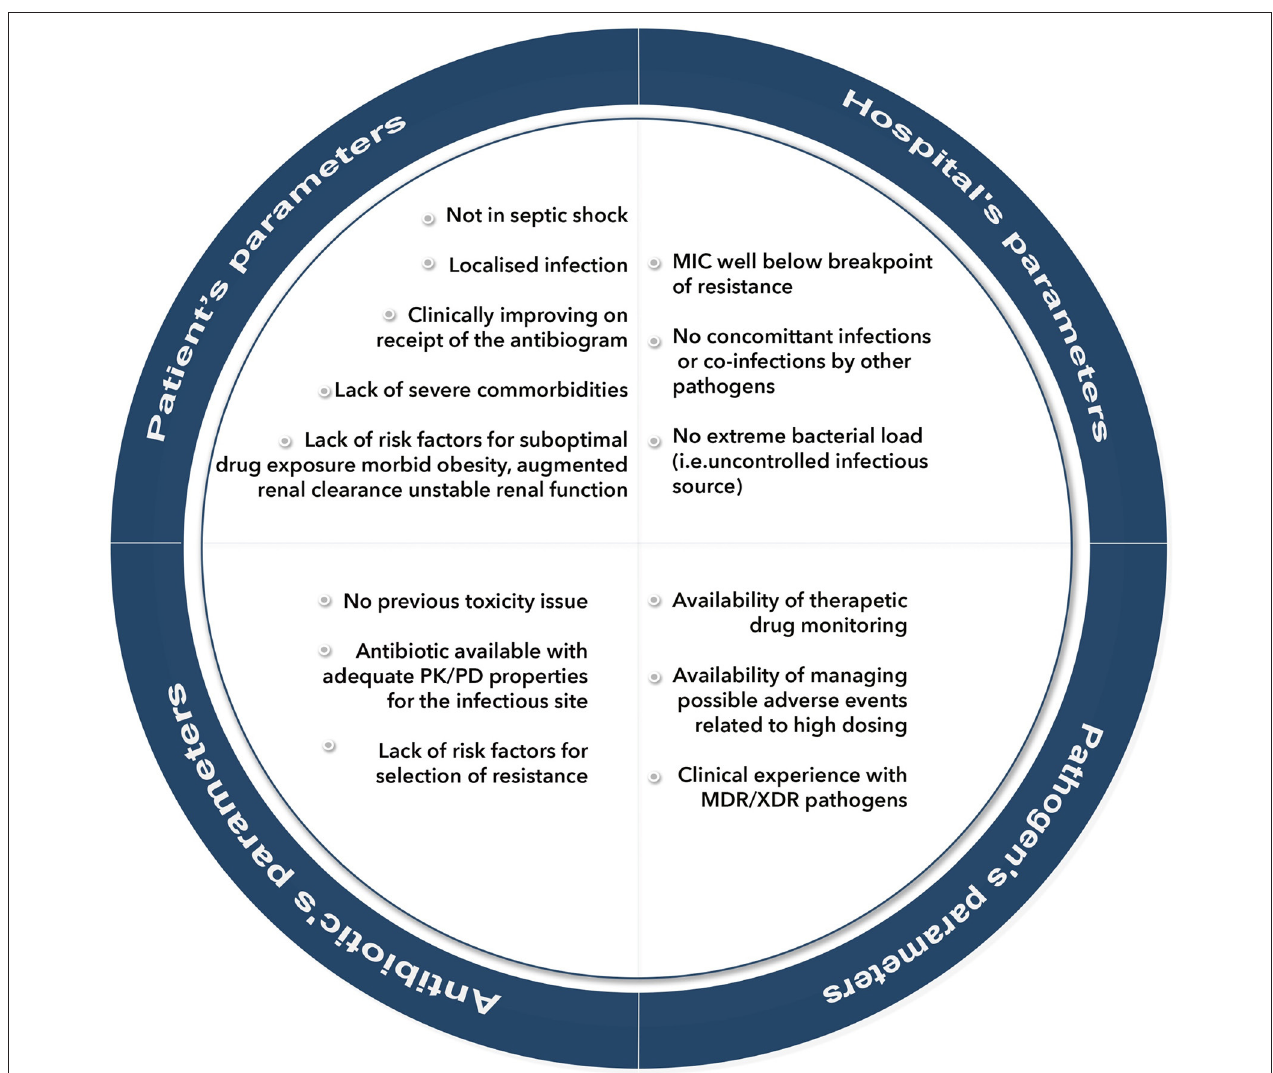
FIGURE 1 | Prerequisite conditions for selecting monotherapy as definitive treatment of infections by extensively-drug-resistant (XDR) pathogens. PK/PD, pharmacokinetic/pharmacodynamic; MDR, multi-drug -resistant; MIC, minimum inhibitory concentration; XDR,